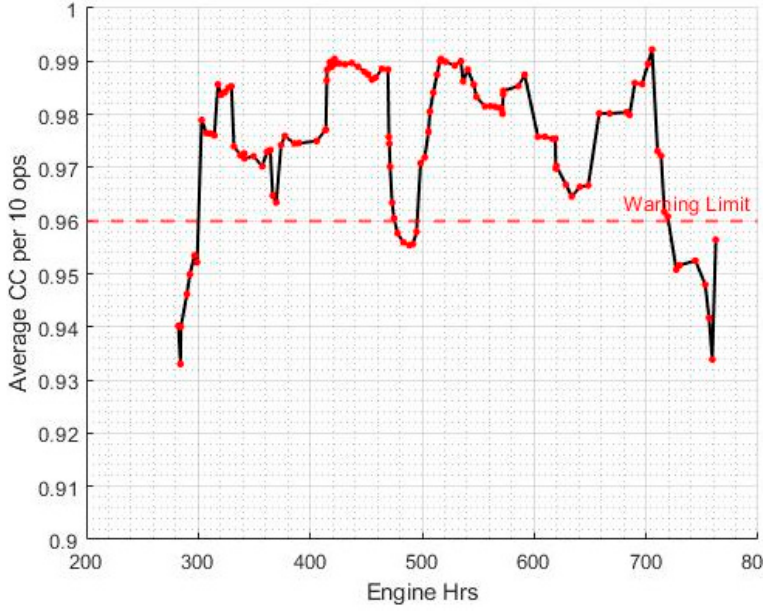
Figure 15. Variation of average CC per 10 operations over time.